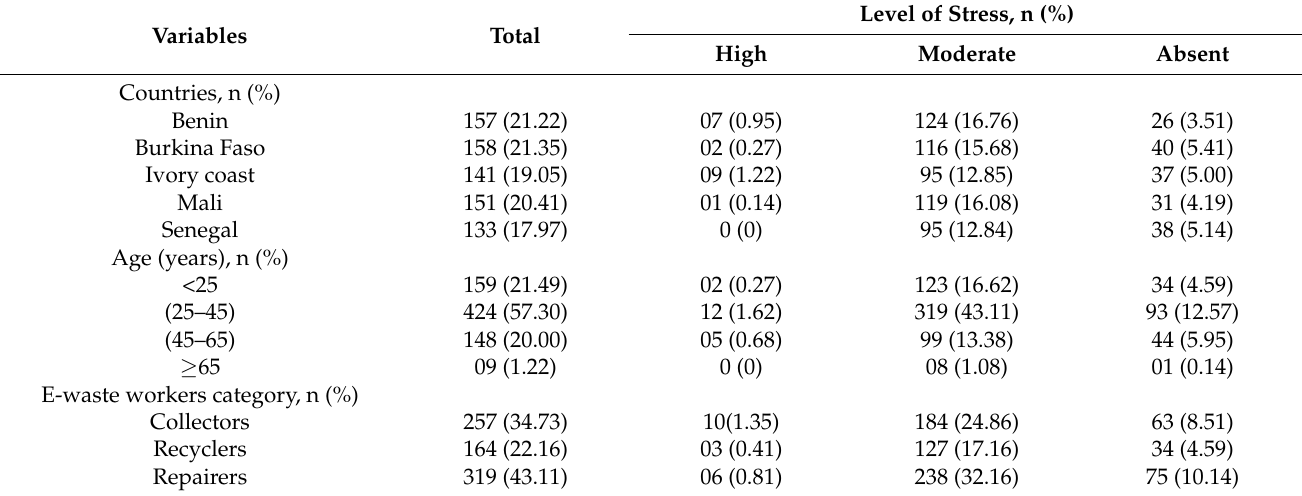
Table 2. General characteristics of study participants based on level of stress.